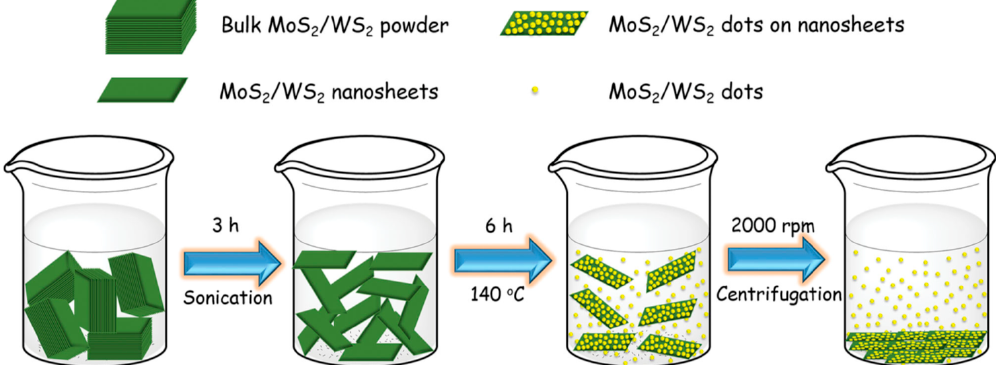
Figure 9. Schematic representation of the synthesis process to prepare MoS 2 and WS 2 quantum dots by using a liquid exfoliation and solvothermal treatment approach. Reproduced with permission from [43]. Copyright WILEY-VCH Verlag GmbH & Co. KGaA, Weinheim, 2015. Many solvents have been tested for their suitability for sonication-assisted exfoliation, with successes including sulfuric acid [60], Dimethylformamide (DMF) [43,51,61], N-Methyl-2-pyrrolidone (NMP) [62], N,N (cid:48) - Dimethylethyleneurea (DMUE) [43], isopropyl alcohol (IPA) [63], and ethylene glycol [64,65]. Deionized (DI) water, ethanol, and acetone have also been tested; however, they were unable to yield MoS 2 QDs [43]. The preparation of MoS 2 QDs through ultrasonic exfoliation has been greatly studied, and prominent results are reported in Table